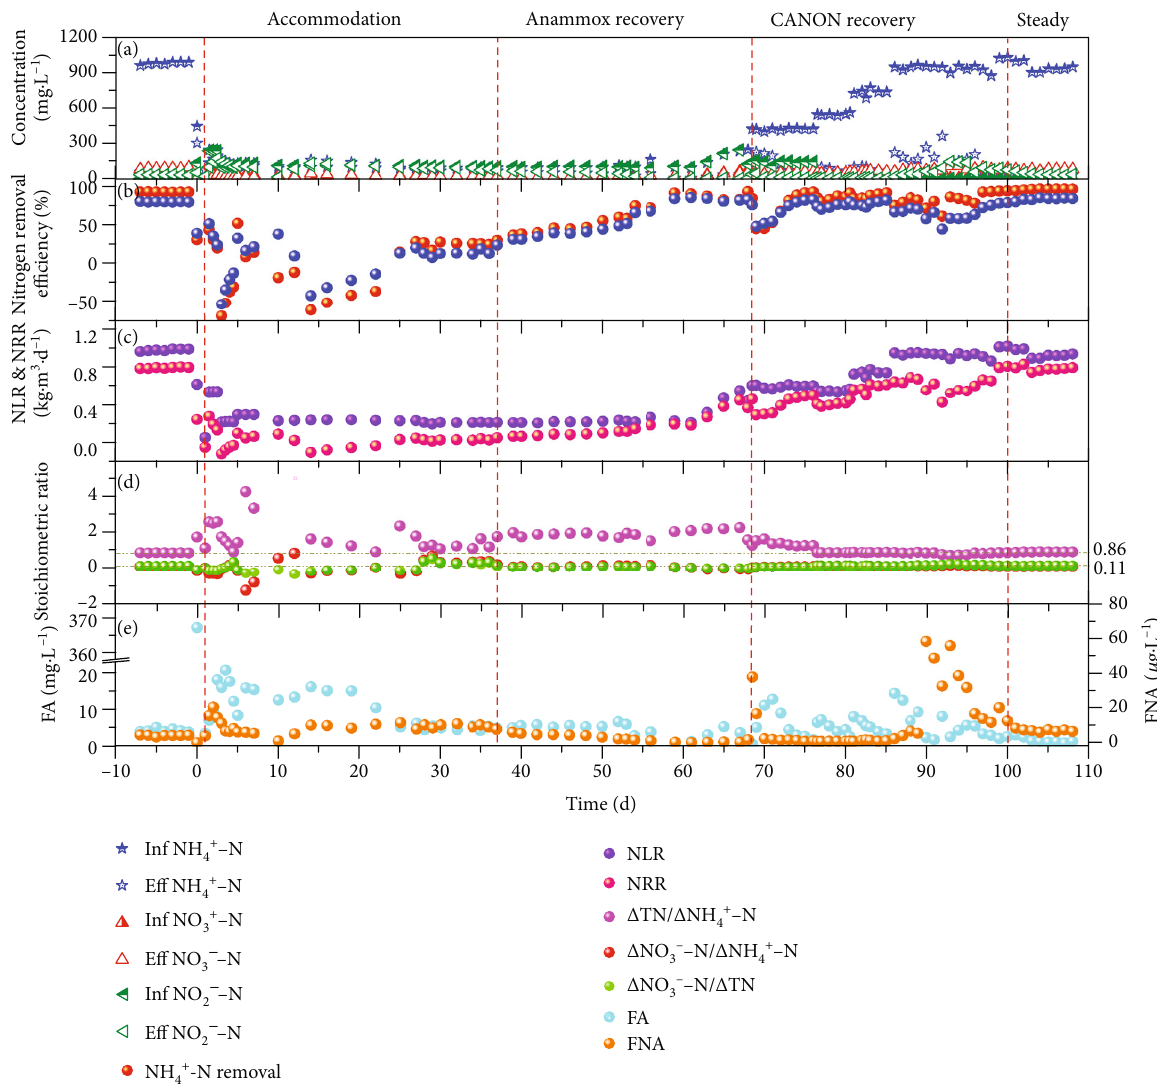
Figure 2: Shifts in nitrogen concentration (a), nitrogen removal e ffi ciency (b), nitrogen loading rate and removal rate (c), stoichiometric ratio (d), and free ammonia and free nitrous acid (e) of the CANON process after alkaline